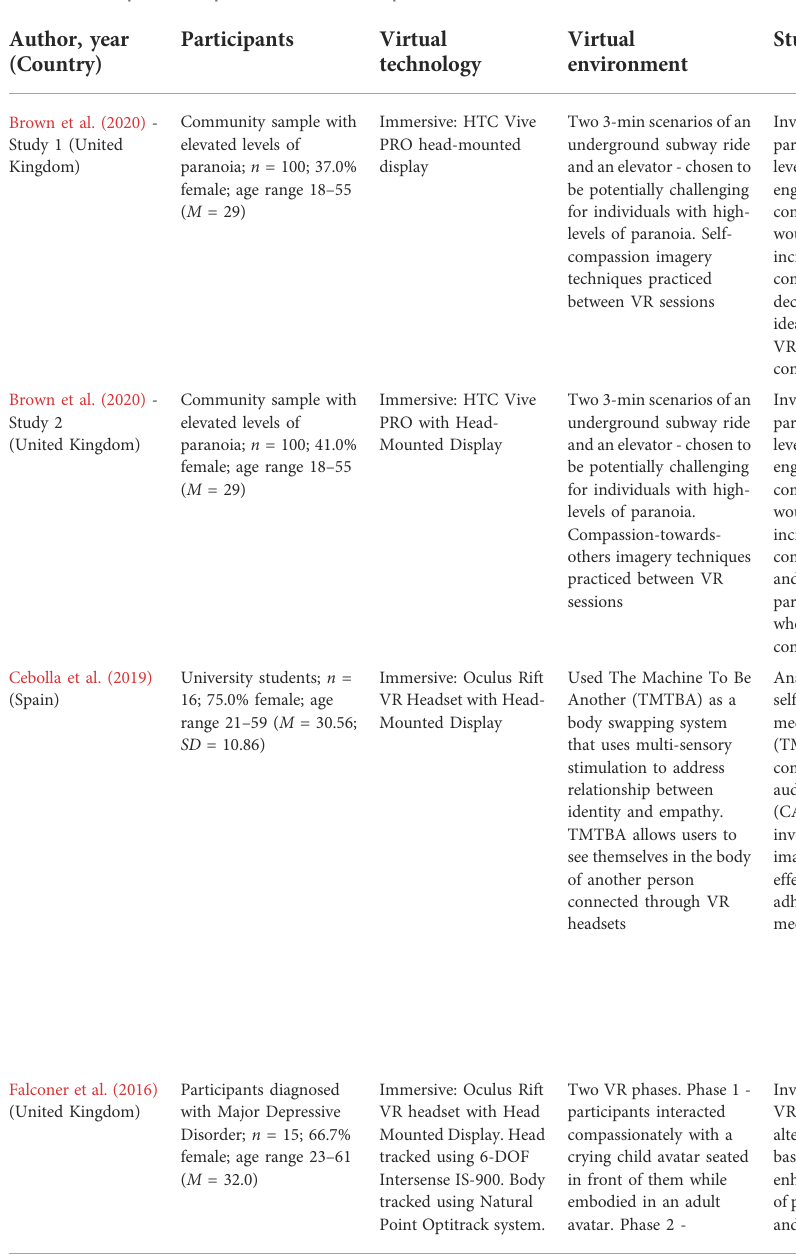
TABLE 4 Examples of empirical studies of compassion-based VR interventions for mental health and